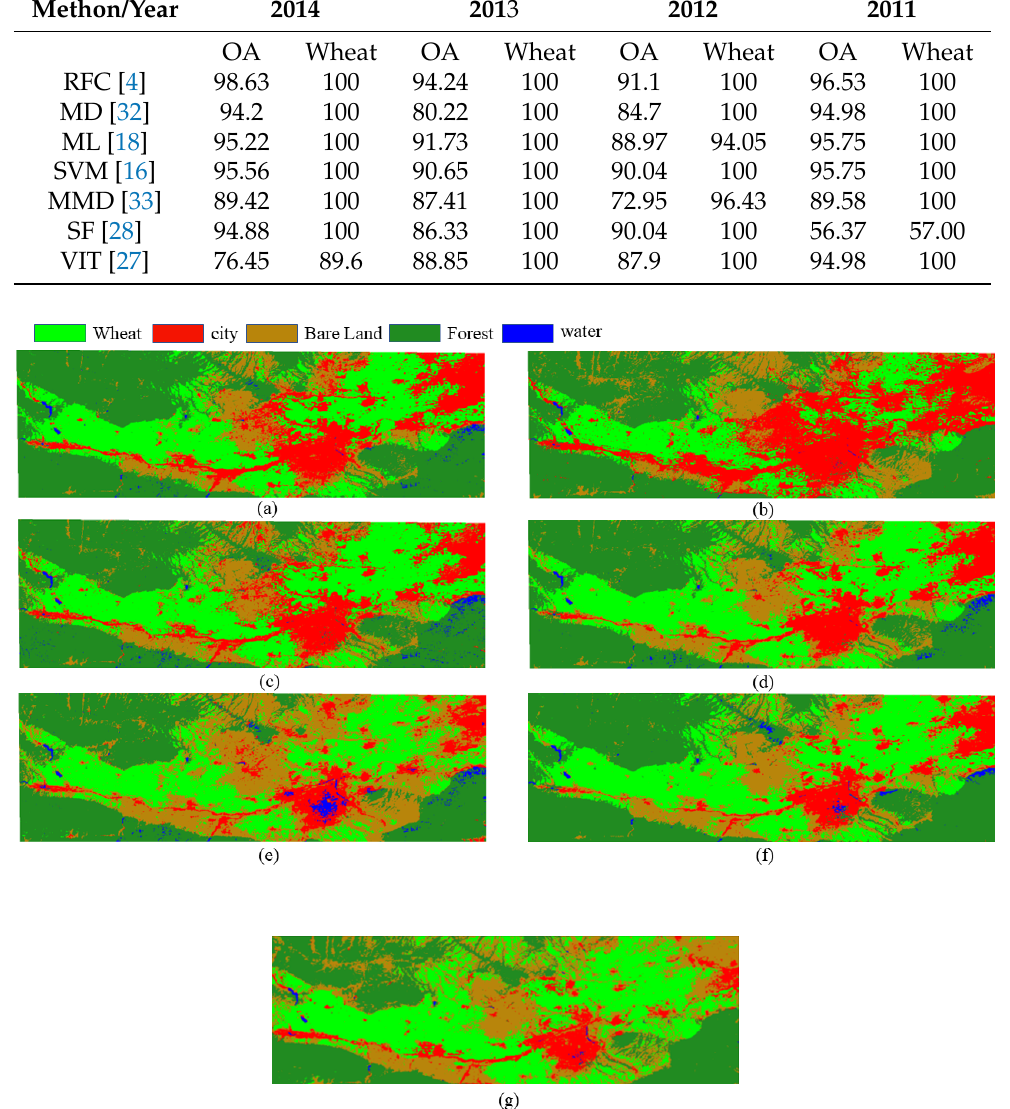
Figure 9. Distribution of winter wheat growing areas and other features obtained after the fusion of different classification methods in 2014. ( a ) A map of the fused distribution obtained by RF. ( b ) A map of the fused distribution obtained by MD. ( c ) A map of the fused distribution obtained by ML. ( d ) A map of the fused distribution obtained by SVM. ( e ) A map of the fused distribution obtained by MMD. ( f ) A map of the fused distribution obtained by SF. ( g ) A map of the fused distribution obtained by